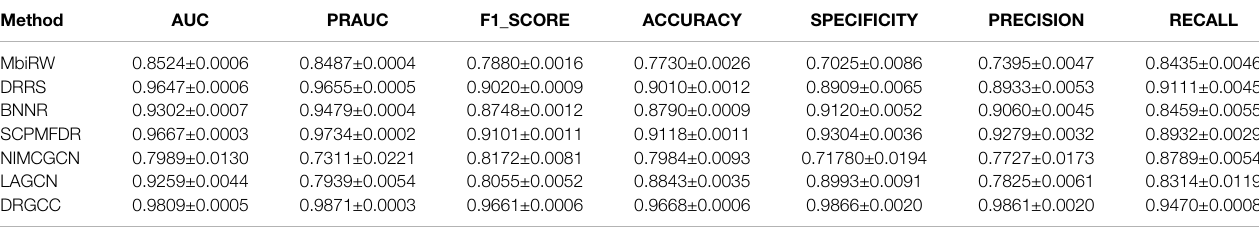
FIGURE 5 | ROC and AUC comparison of DRGCC with different TABLE 3 | Performance of comparison methods on CTD dataset.